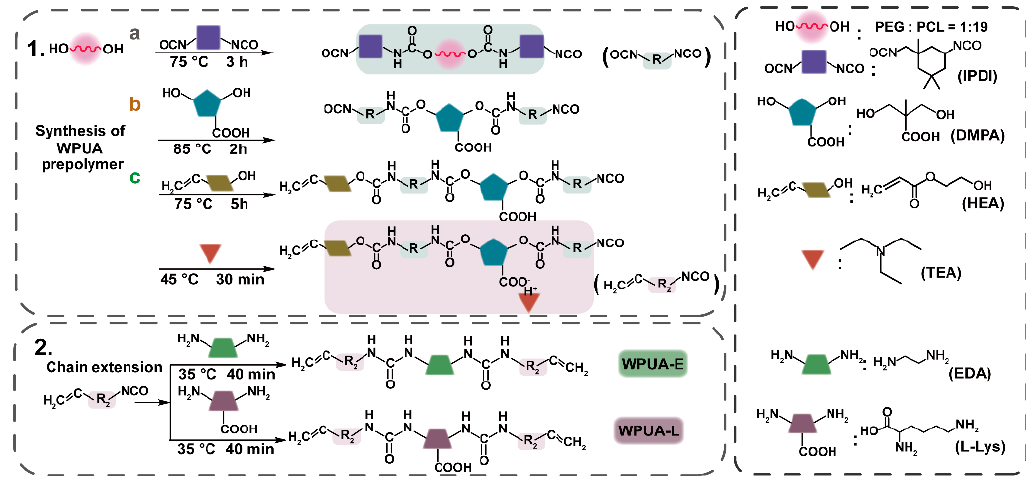
Figure 2. Synthetic route of two WPUAs with EDA and L − Lys as chain extenders. The two chain extenders (EDA and L − Lys) were dissolved in deionized water and added to the oligomer system dropwise with vigorous stirring (1200 rpm) for 40 min. Then, a solid content of 30% WPUA emulsion was obtained. WPUAs synthesized with EDA and L − Lys as chain extenders were named WPUA − E and WPUA − L, respectively. The stoichiometric ratios of reactants are listed in Table S1. At last, photoinitiator VA − 086 (2 wt.% to solid content) was added and mixed uniformly. The remaining MEK and